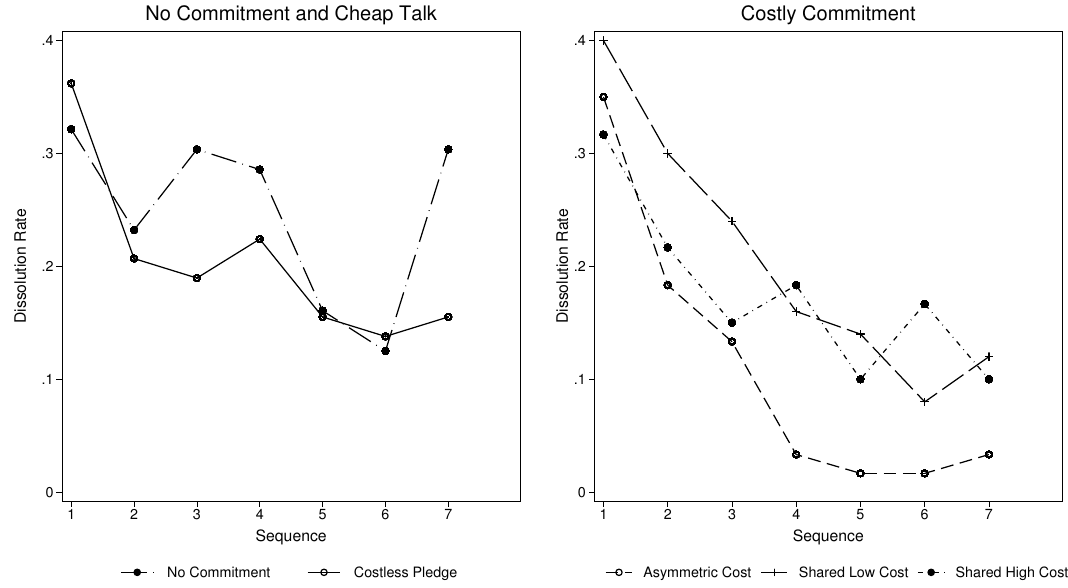
Figure 5. Partnership dissolution rates by treatment and